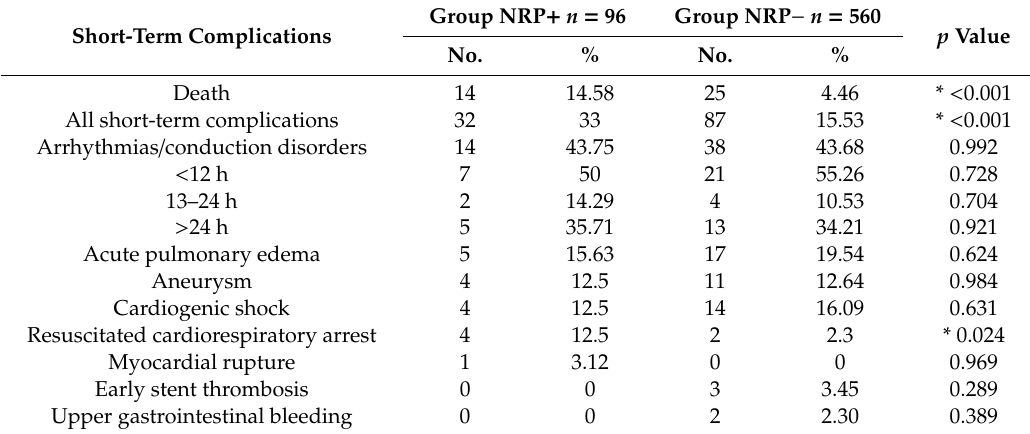
Table 2. Short-term complications in both